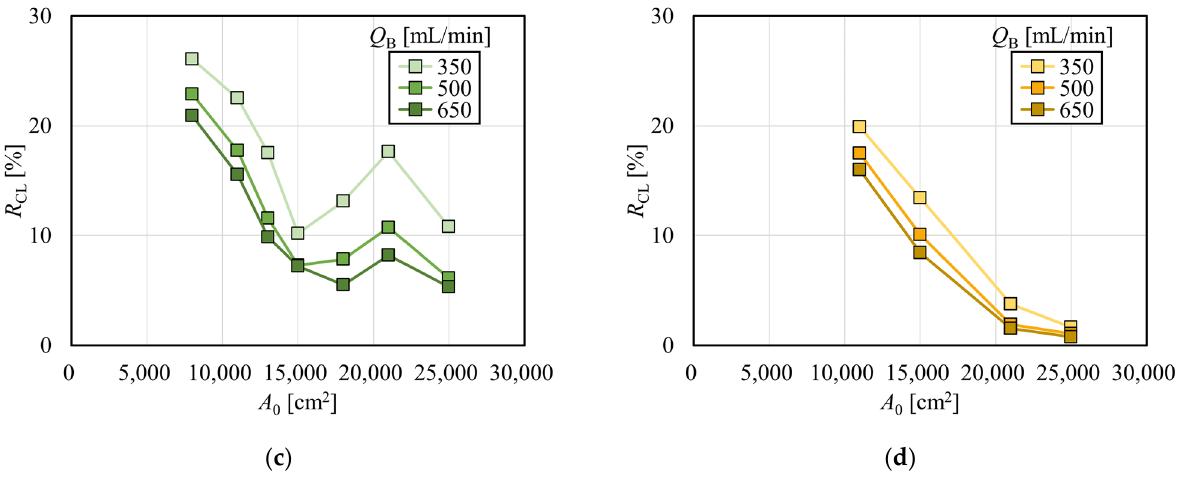
Figure 3. Effect of membrane fouling on the solute removal performance. ( a ) Creatinine clearances in APS-SA series with and without immobilization of albumin ( Q D = 500 mL/min, n = 3). ( b ) Creatinine clearances in MFS-S eco series with and without immobilization of albumin ( Q D = 500 mL/min, n = 3). ( c ) Reduction rate of clearance in APS-SA series. ( d ) Reduction rate of clearance in MFX-S eco series.